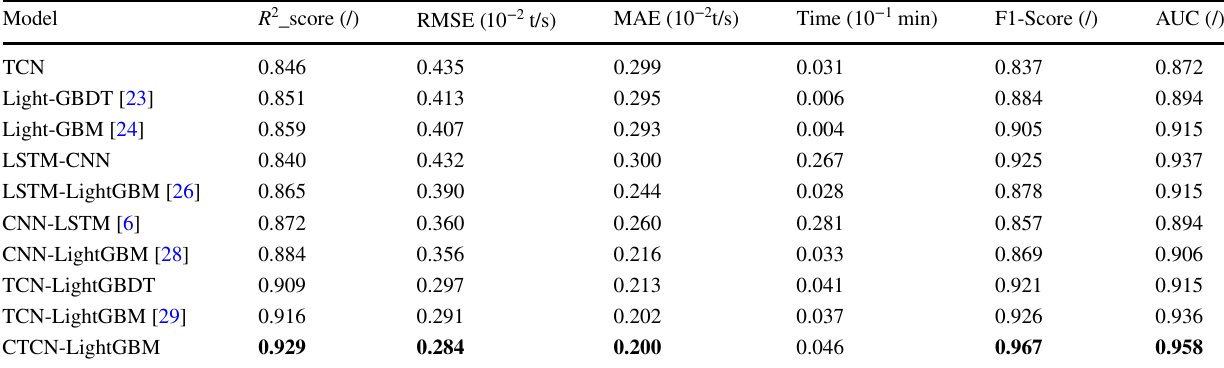
The bold values indicate superior metric values of the proposed